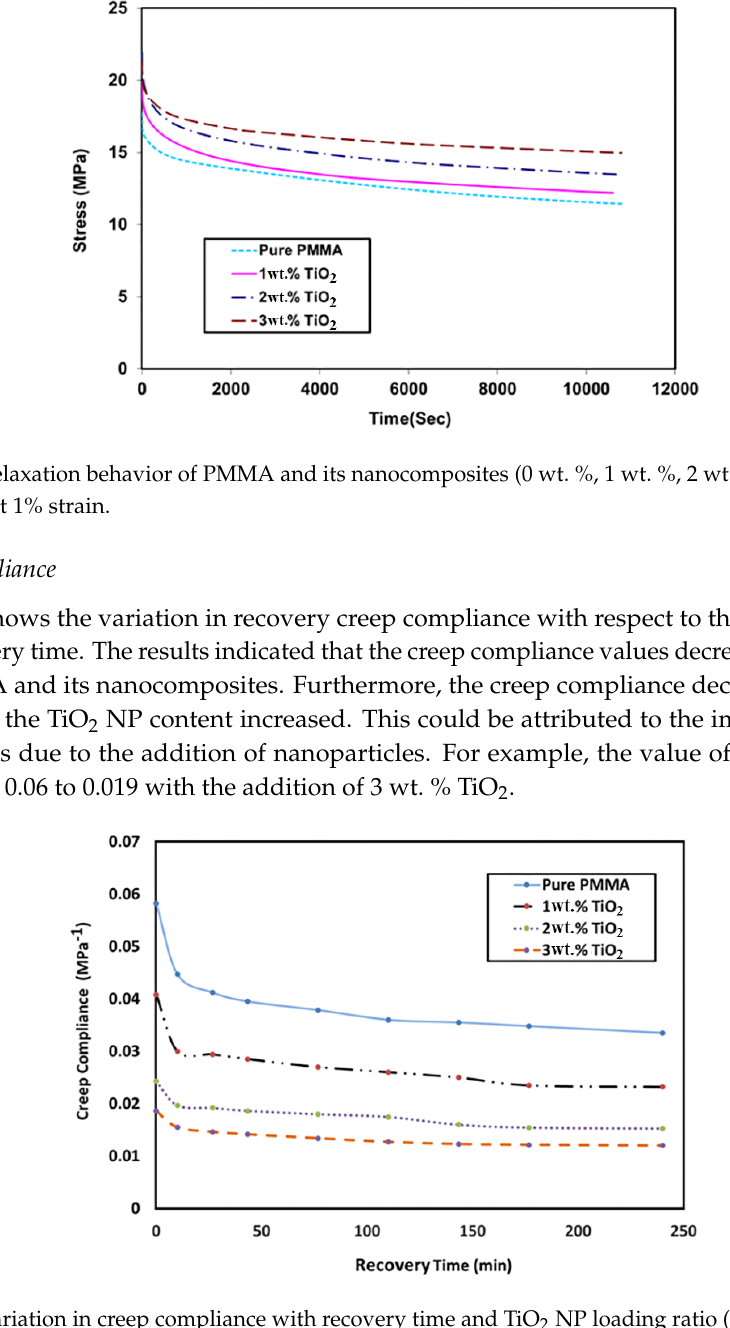
Figure 8. Variation in creep compliance with recovery time and TiO 2 NP loading ratio (0 wt. % 1 wt. %, 2 wt. % and 3 wt. % TiO 2